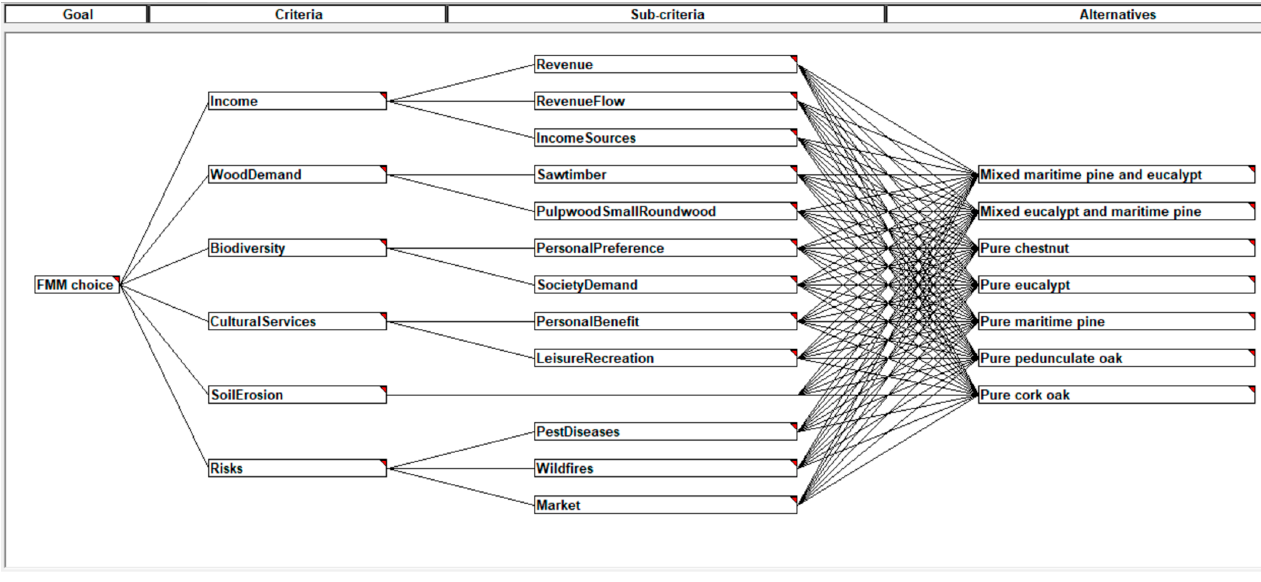
Figure 4. Decision tree (designed by the authors, using the software CDP).